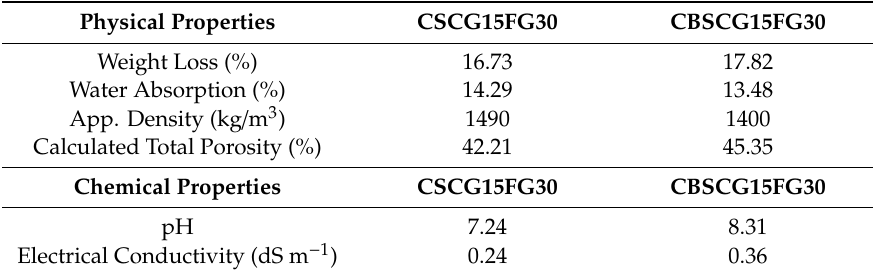
Table 1. Physical and chemical parameters of the lightweight aggregates